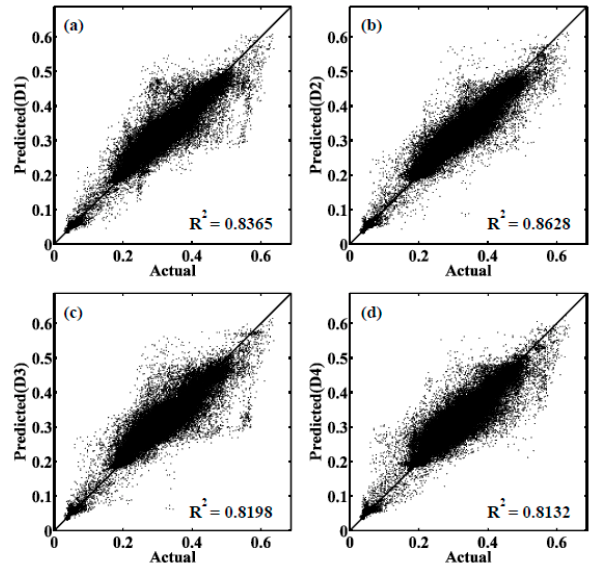
Figure 7. Scatter plots of reflectance values of band 4 for bivariate cases, with ( a – d ) corresponding to B-D1, B-D2, B-D3 and B-D4. X axis reflects the actual reflectance while the Y axis is the